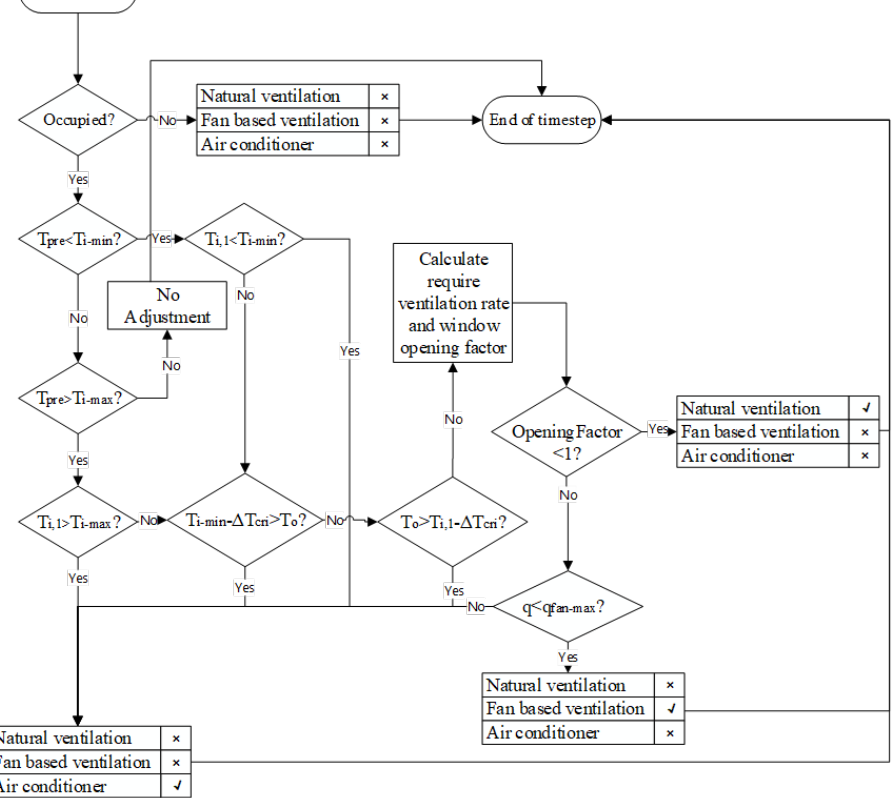
Figure 1. The control logic of the rule-based model; q fan − max is the maximum air flow rate of the supply fan, which was set to 0.075 m 3 /s in this